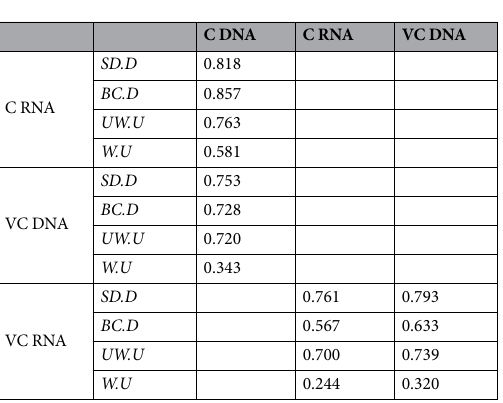
Table 1. Beta diversity patterns in the four datasets (VC DNA, C DNA, VC RNA, C RNA) examined using Sörensen-Dice Distance ( SD.D ), Bray–Curtis Dissimilarity ( BC.D ), Unweighted UniFrac ( UW.U ) and